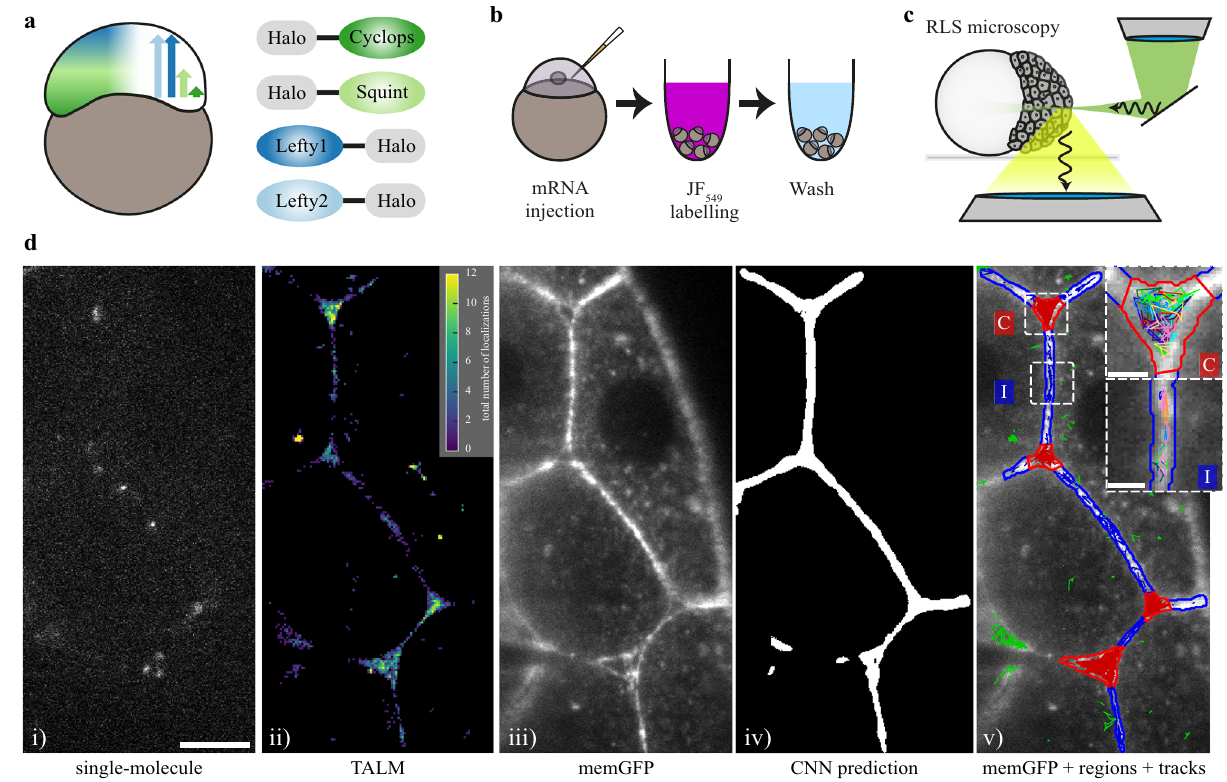
Fig. 1 | Single-molecule imaging of HaloTag-labeled Nodal and Lefty in live zebra fi sh embryos using RLSM. a Schematic of the presumed concentration gradients of Nodal (dark and light green) and Lefty (dark and light blue) in early zebra fi sh embryos (left) and sketch of HaloTag fusion proteins of mature Cyclops, mature Squint, Lefty1 and Lefty2 (right). b Schematic of the labeling work fl ow: mRNA encoding the fusion proteins was injected at the one-cell stage. Embryos wereincubatedinmediumcontainingtheHaloTagJF-549ligandtocovalentlylabel the HaloTag. Excess dye was removed in washing steps. c Sketch of a zebra fi sh embryo imaged with a re fl ected light-sheet microscope. d Work fl ow of single- molecule imaging and image segmentation: i) signal of single Lefty2-HaloTag